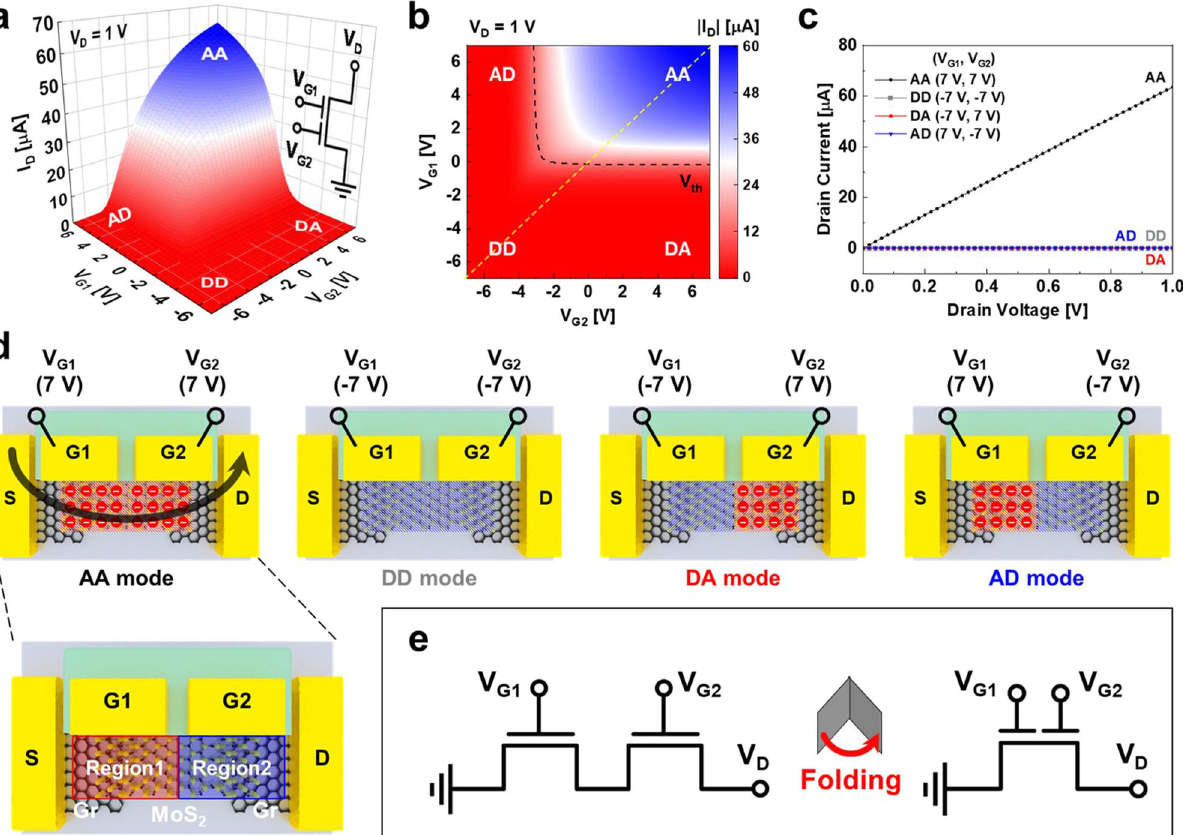
Fig. 2 Electrical characteristics and operating schematics of AND-FET. a , b 3D color surface ( a ) and contour color map ( b ) of I D in the AND- FET at each V G1 and V G2 value in the range from – 7 to 7 V with V D of 1 V. c I D – V D output characteristics of the four distinct transition modes of the AND-FET. d The operating schematics for the four distinct transition modes (AA, DD, DA, and AD modes). e Circuit diagrams showing how the same switching function can be achieved with a single transistor (horizontally folded